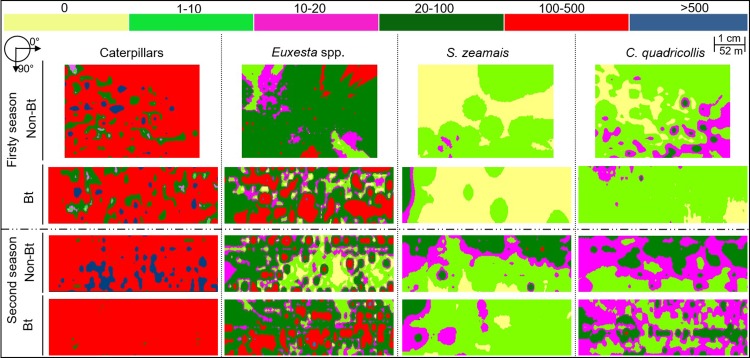
Spatial distribution of corn injury by caterpillars (Helicoverpa spp. + Spodoptera frugiperda), the cornsilk fly (Euxesta sp.), square-necked grain beetle (C. quadricollis), and the maize weevil (S. zeamais) in Bt (Cry1Ab) and non-Bt corn crops in the 2008/09 and 2009/10 seasons.Angle 0° = along the corn row and 90° = direction between corn rows. The maps are from infestations in Cajuri county, State of Minas Gerais, Brazil.